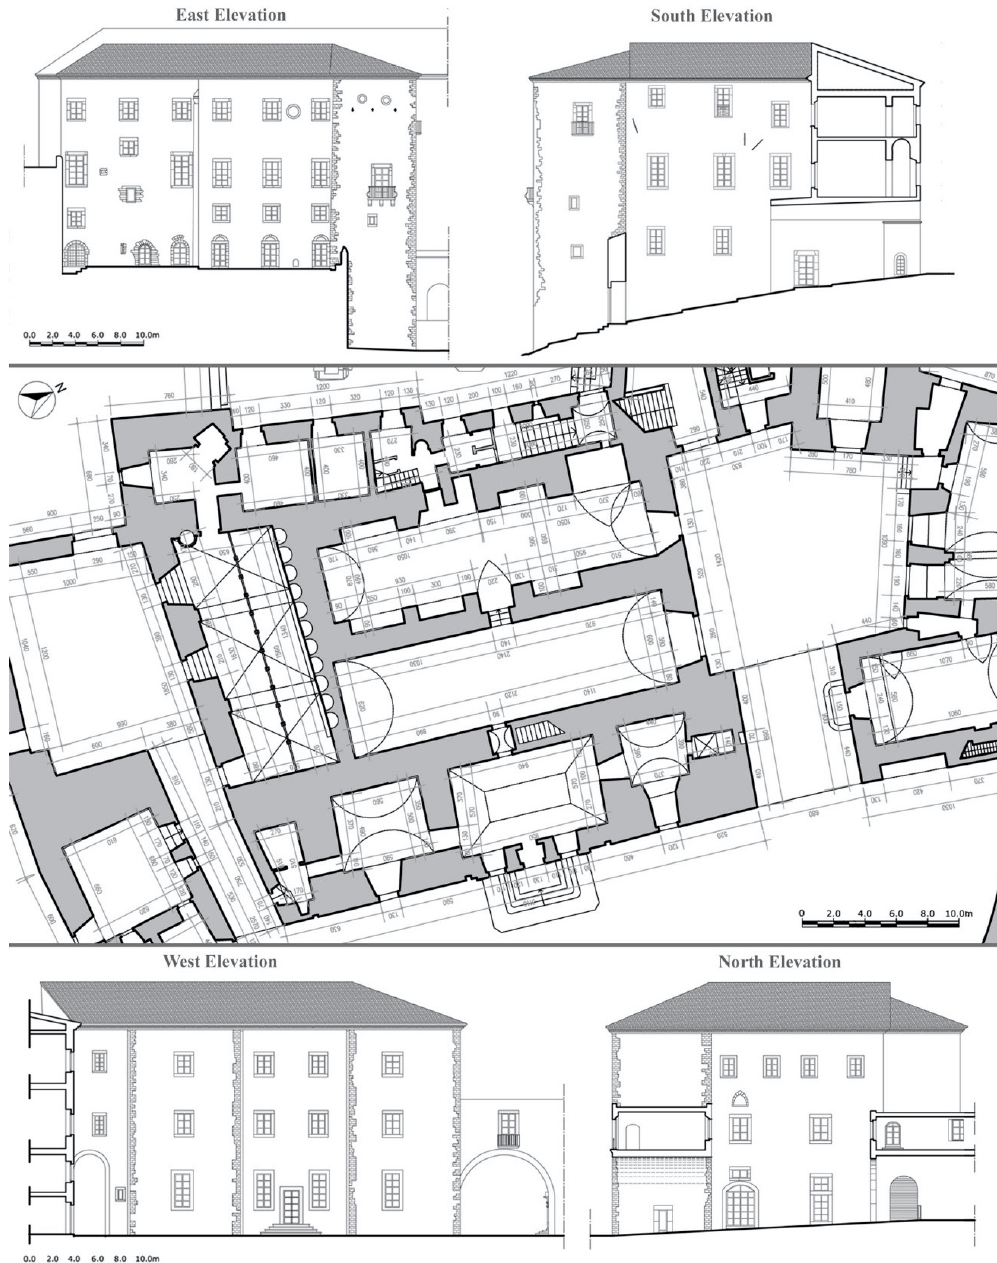
Figure 6. Geometric survey of the ground floor and the elevations of the central part of the Castle of Melfi (PZ),